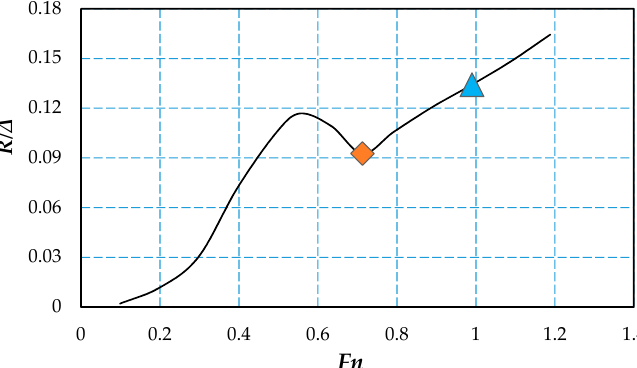
Figure 8. Test speeds on the curve of non-dimensional resistance versus Froude